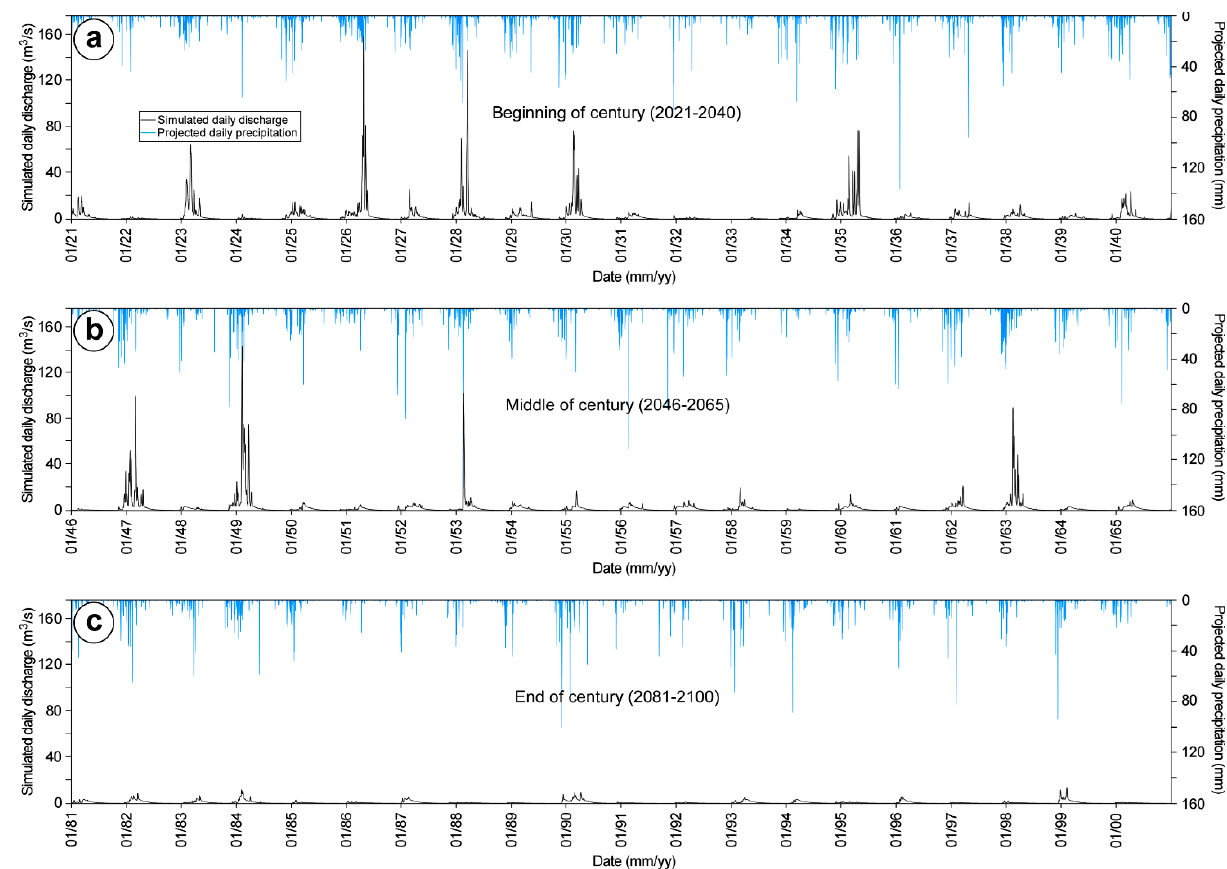
Figure 7. Simulated daily discharge and projected precipitation at the Alata River Basin outlet gauging station (D17A040) at Sarılar at ( a ) the beginning of the century, ( b ) the middle of the century and ( c ) the end of the century climates, based on the RCP8.5 scenario.